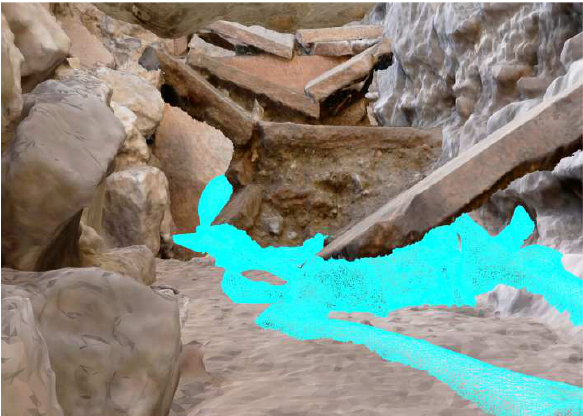
Figure 3. View of tomb 37 exported by Esri ArcScene: particular of the coverage collapsed on the skeleton.